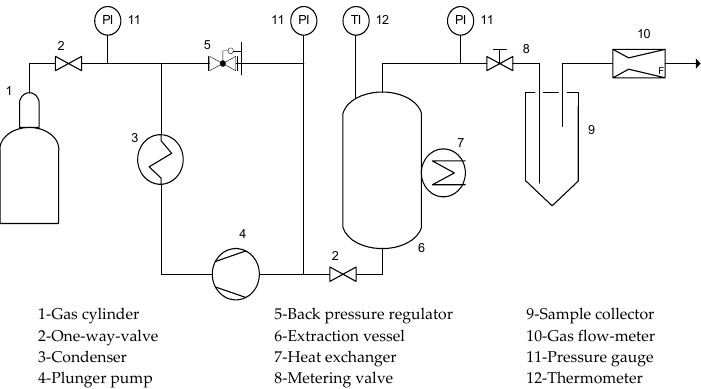
Figure 1. Flow-sheet of the extraction